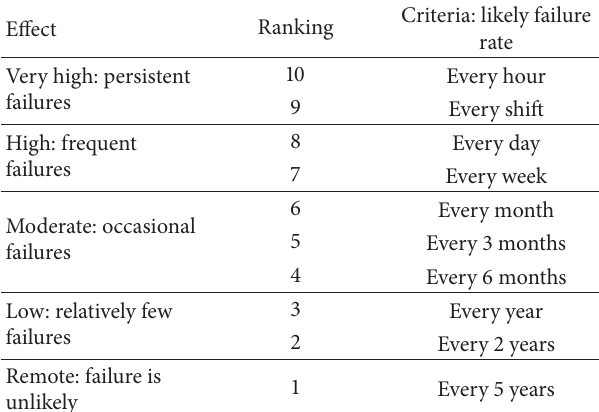
Table 2: Occurrence evaluation